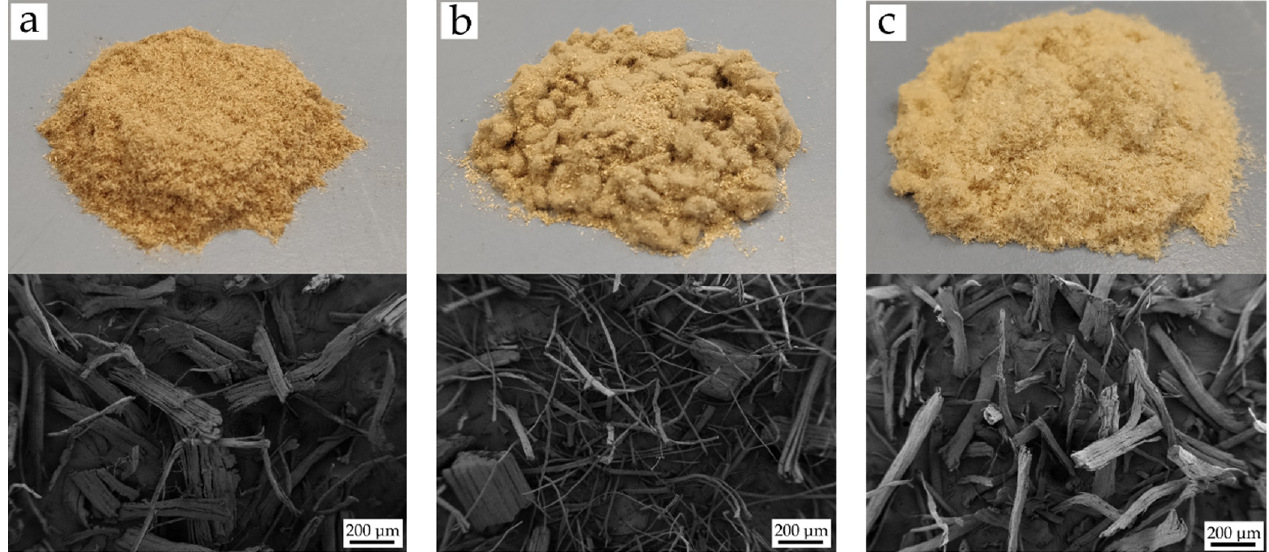
Figure 1. Visual appearance (upper row) and field emission scanning electron microscopy (FESEM) images at 50 × (bottom row) of different natural fibers: ( a ) Hemp; ( b ) Flax; ( c ) Jute.